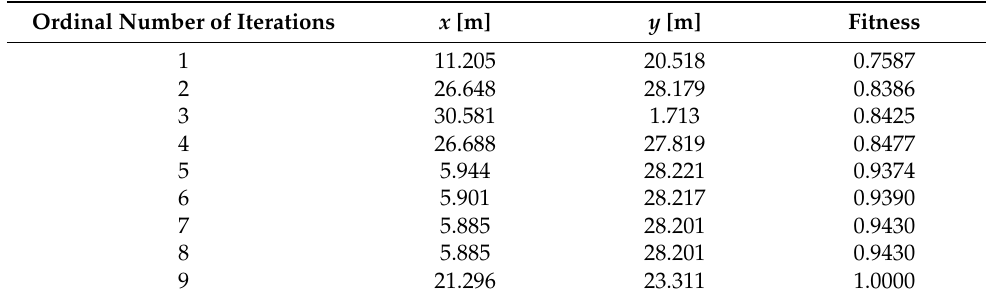
Table 3. Search information of detecting points for 10 random searches based on particle swarm optimization.